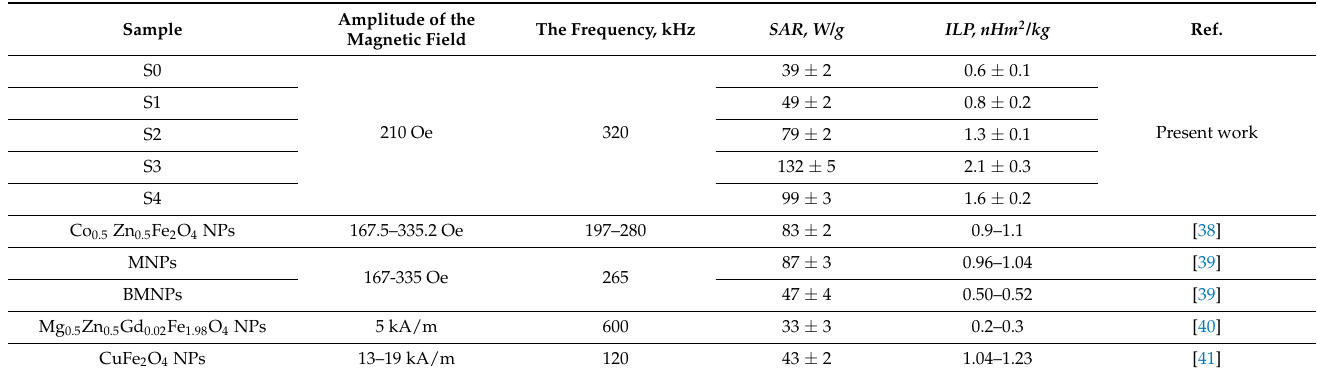
Table 2. Comparison of the obtained SAR and ILP data with the literature data, taking into account the conditions of exposure to the magnetic